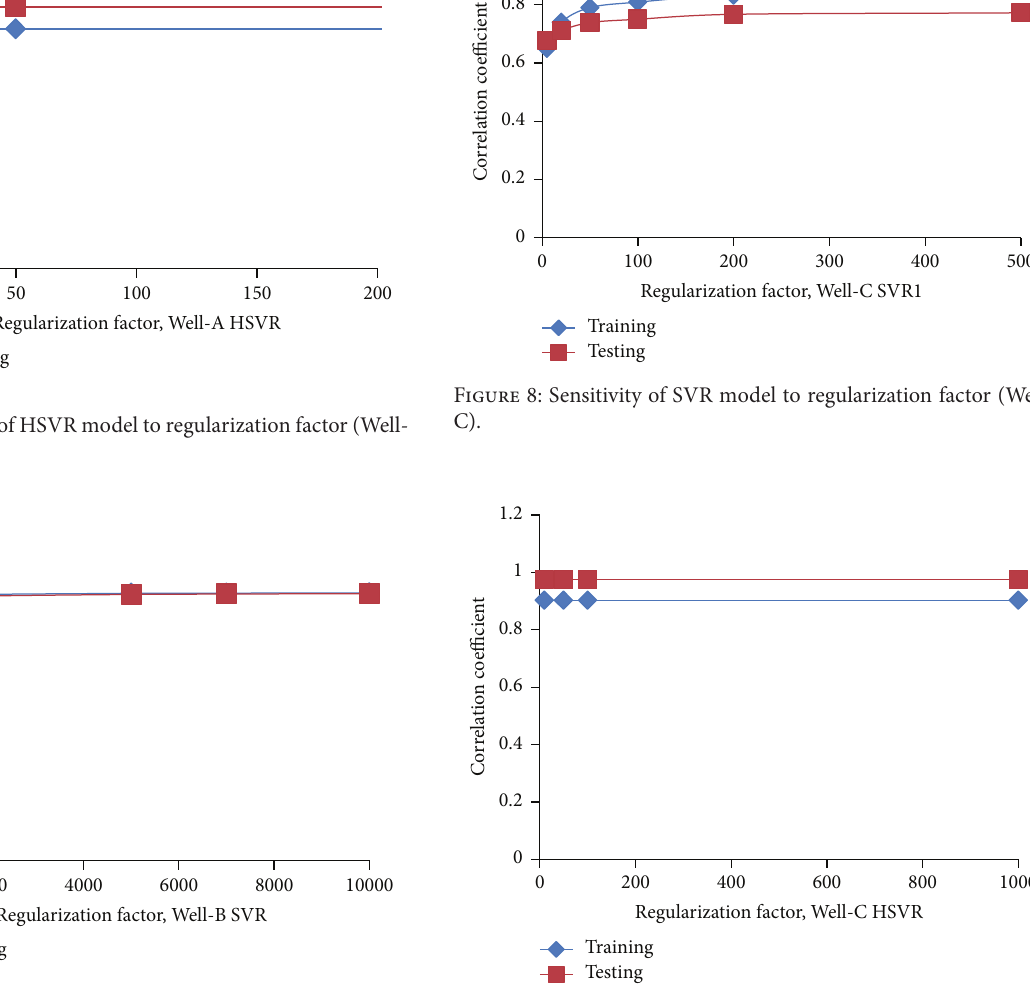
Figure6:SensitivityofSVRmodeltoregularizationfactor(Well-B).